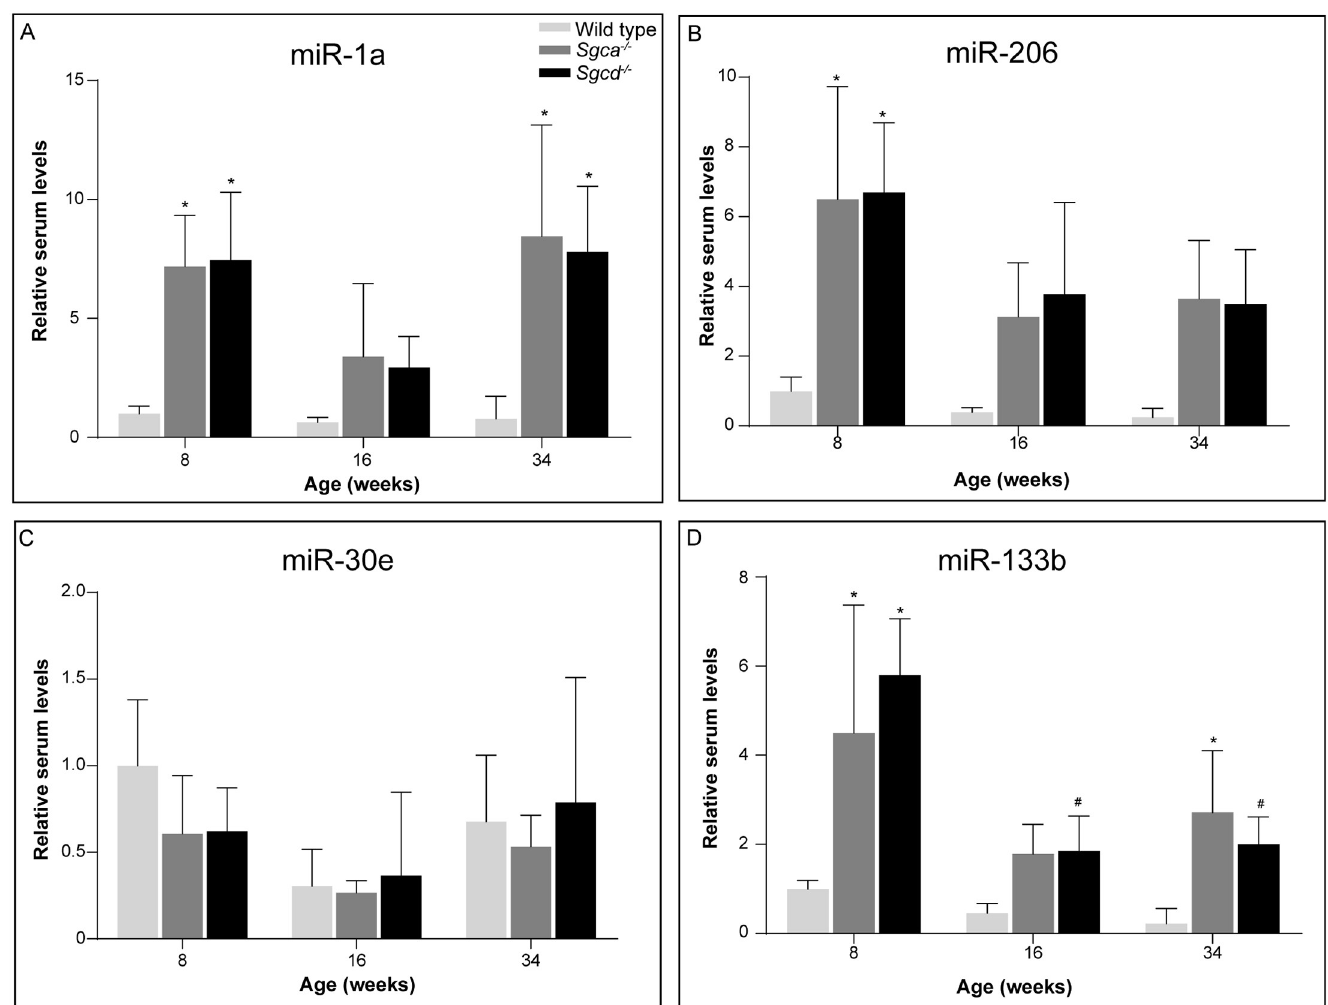
Fig 6. miRNA serum levels. (A-D) Relative levels of miR-1a (A), miR-206 (B), miR-30e (C) and miR-133b (D) in 8, 16 and 34 weeks old mice. N = 4-6 male mice per group. For miR-30e, the level of 16-weeks-old wild type mice is based on n = 3. Levels of 8-weeks-old wild type mice were put at 1. � p < 0.05 vs age-matched wild type mice, # p < 0.05 over time (same genotype).